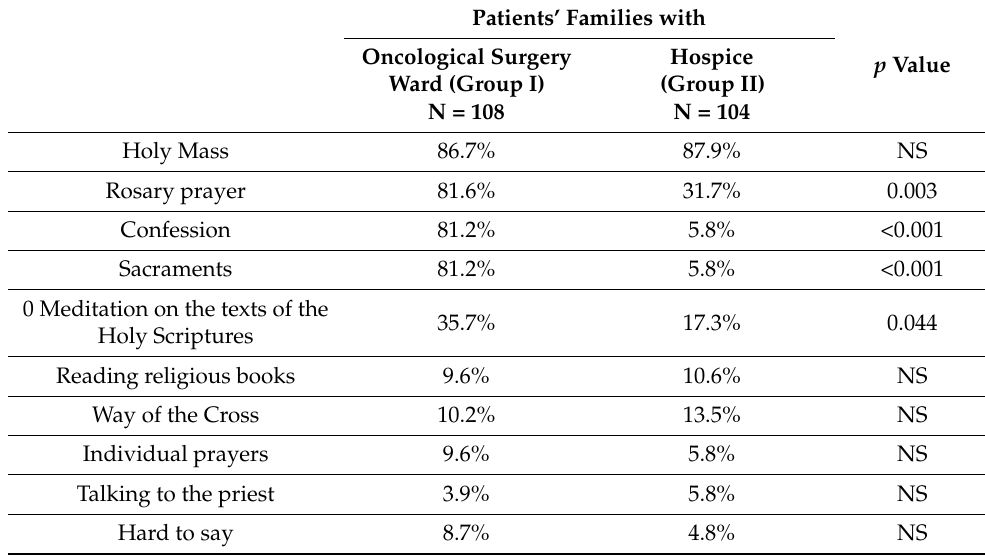
Table 11. Respondents’ opinions on the desired religious practices in hospice